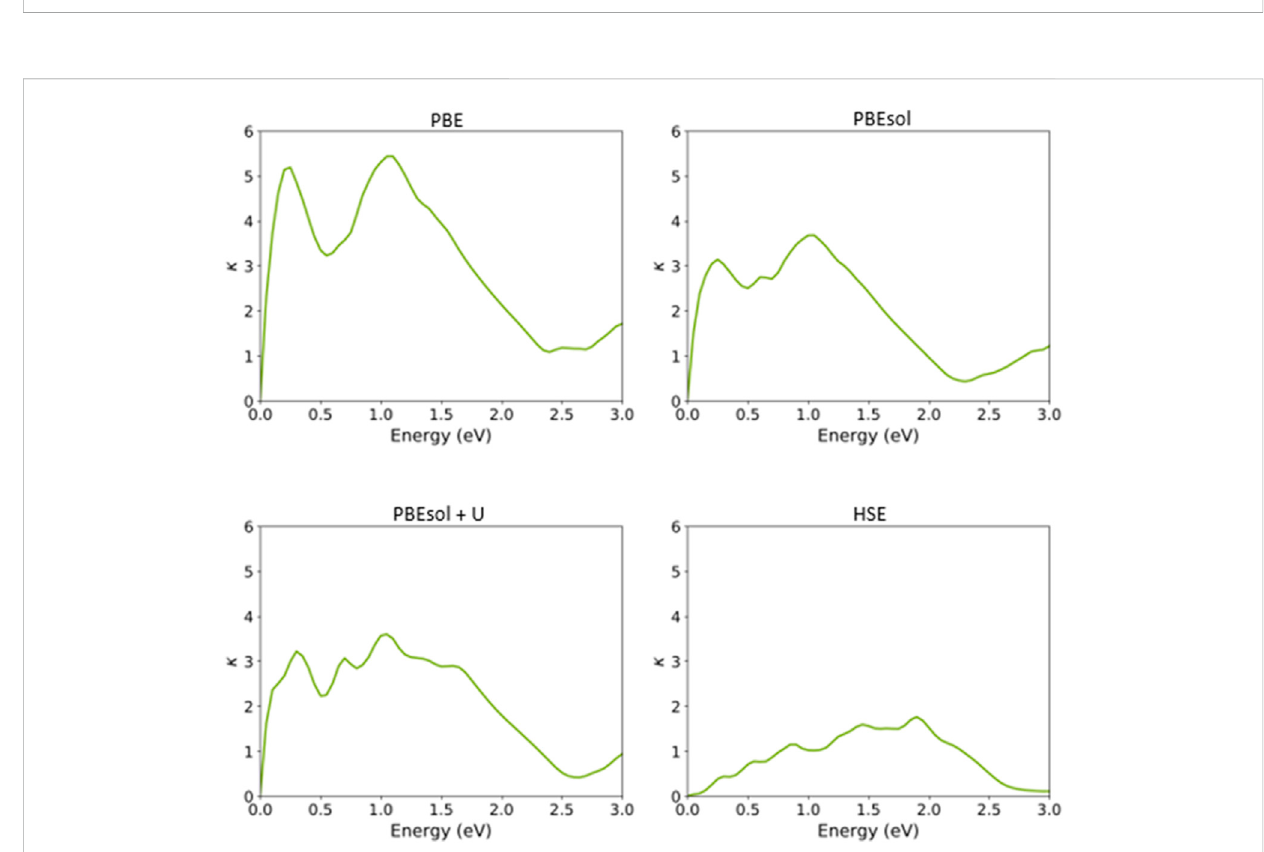
FIGURE 9 Extinction coef fi cient of the VO 2 (M) polymorph as a function of the energy (eV), predicted by the PBE, PBEsol, PBEsol + U, and HSE functionals.